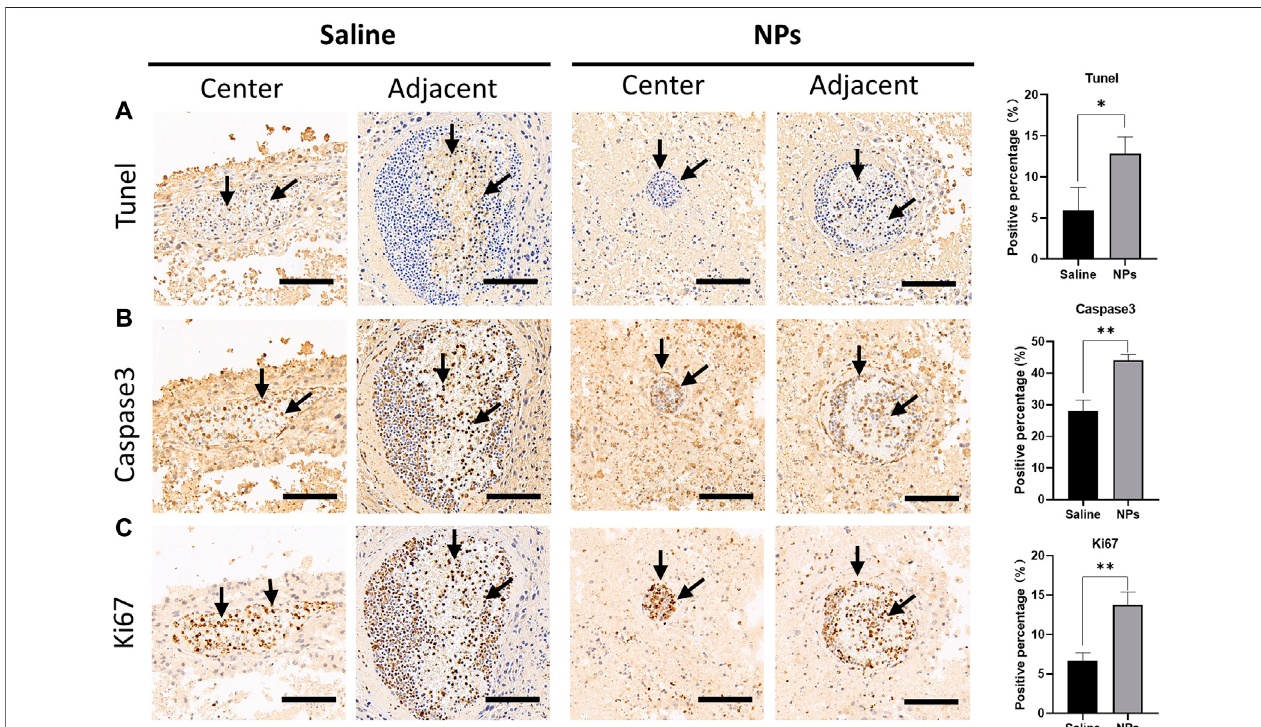
FIGURE 6 | Immunohistochemical staining of tumor apoptosis indicators after injection of nanoparticles in the tumor. (A) Microscopic photos of TUNEL staining in the central and adjacent areas of the puncture site in saline and nanoparticle injection groups and comparison of the positive percentage between the two groups (* p < 0.05). (B) Microscopic photos of caspase 3 staining in the central and adjacent areas of the puncture site in each group and comparison of the positive percentage betweenthetwogroups(** p < 0.01). (C) MicroscopicphotosofKi67staininginthecentralandadjacentareasofthepuncturesiteineachgroupandcomparisonof the positive percentage between the two groups (** p < 0.01). Scale bar = 100 um.